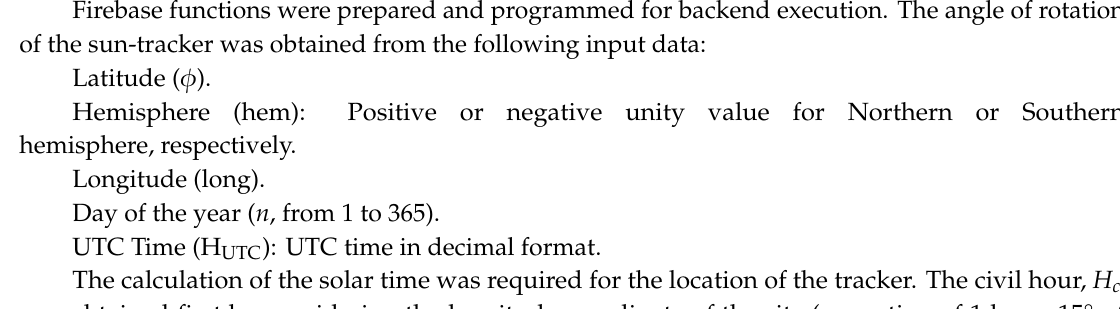
Figure 10. Database function.